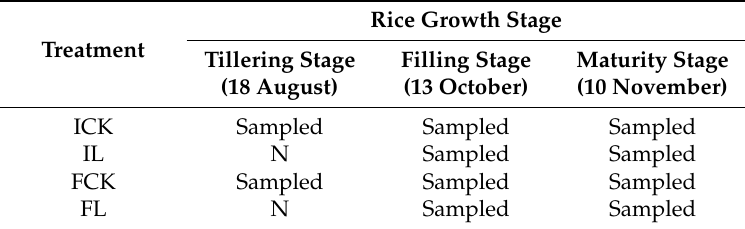
Table 2. Sampling time of each